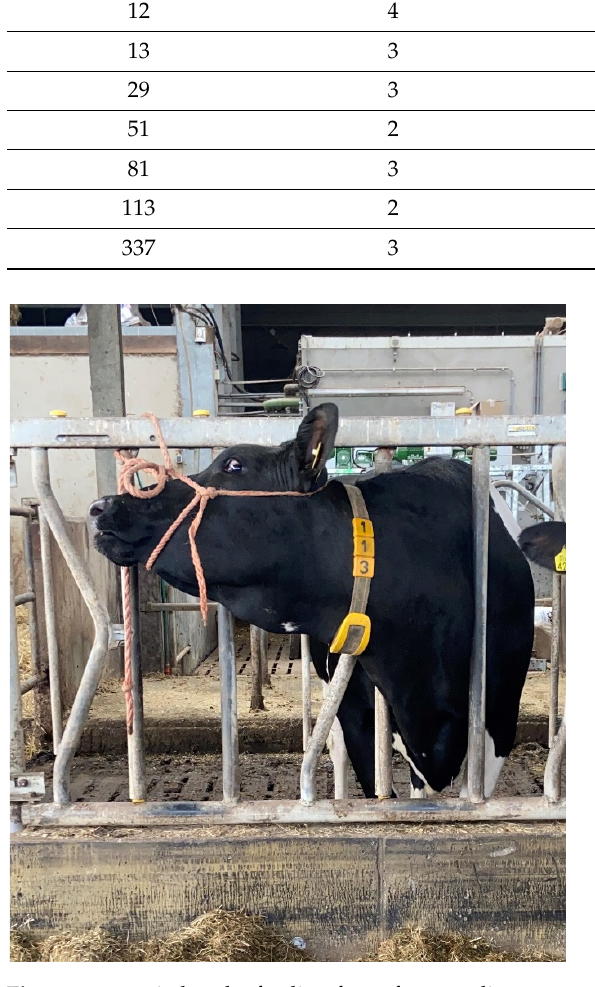
Figure 1. cow tied to the feeding fence for sampling.